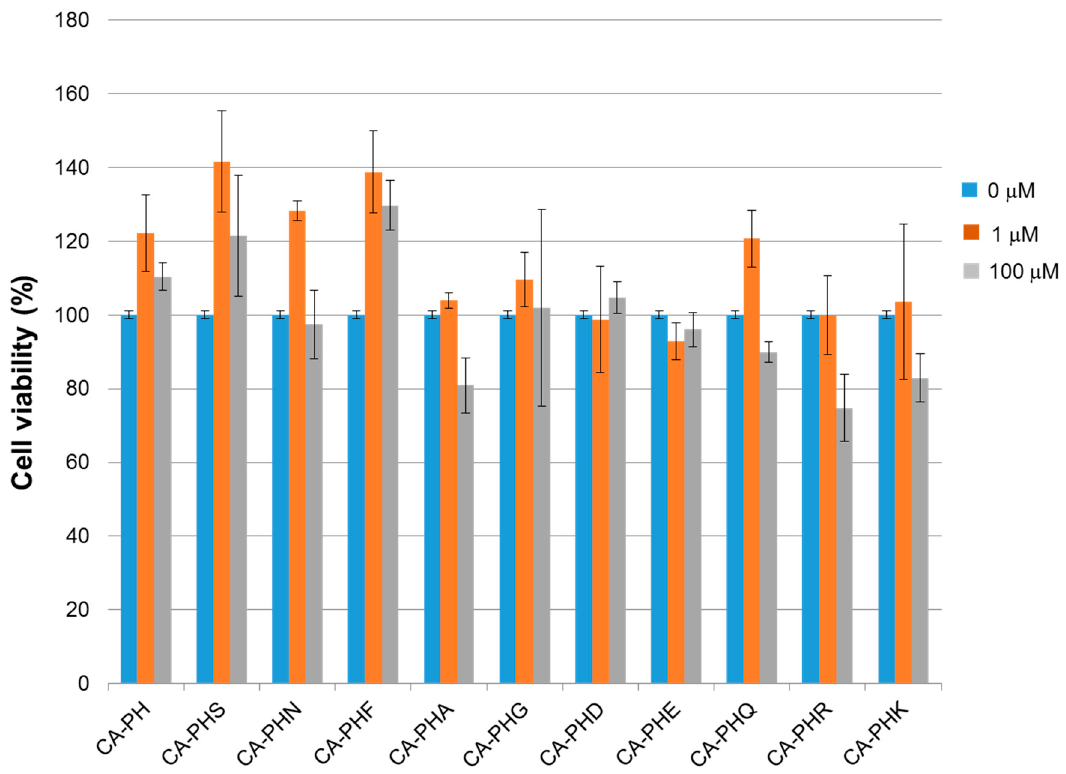
Figure 4. Cytotoxicity of the CA-PHX-NH 2 derivatives measured using MTT assay. Each experiment was performed in triplicate. Results are presented as mean ± standard error.